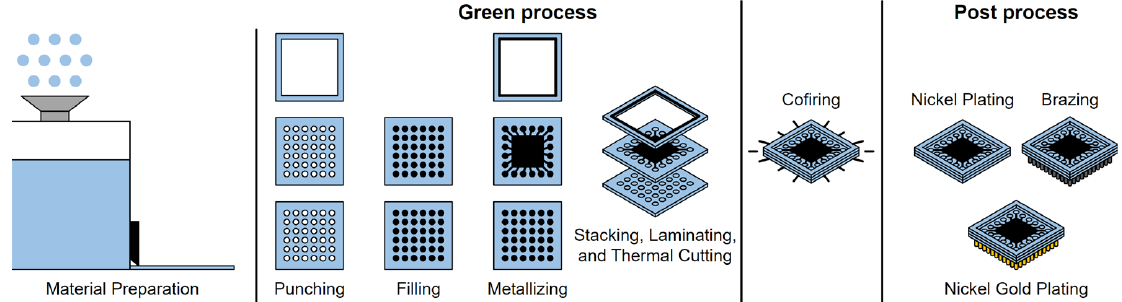
Figure 1. Cofired ceramic process.